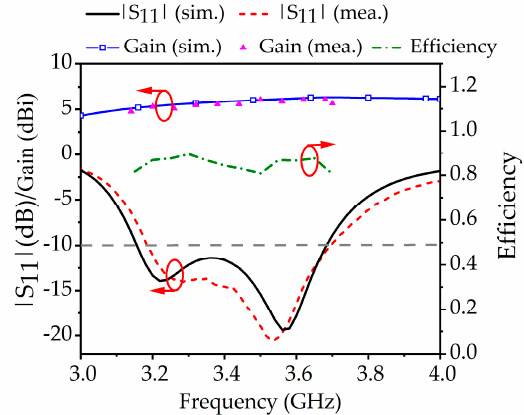
Figure 8. The simulated and measured |S 11 |s, gains, and efficiency.